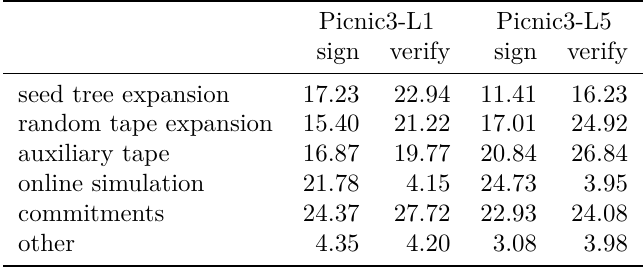
Table 7: Cost breakdown of signing and verification of the Picnic3 parameter sets (as